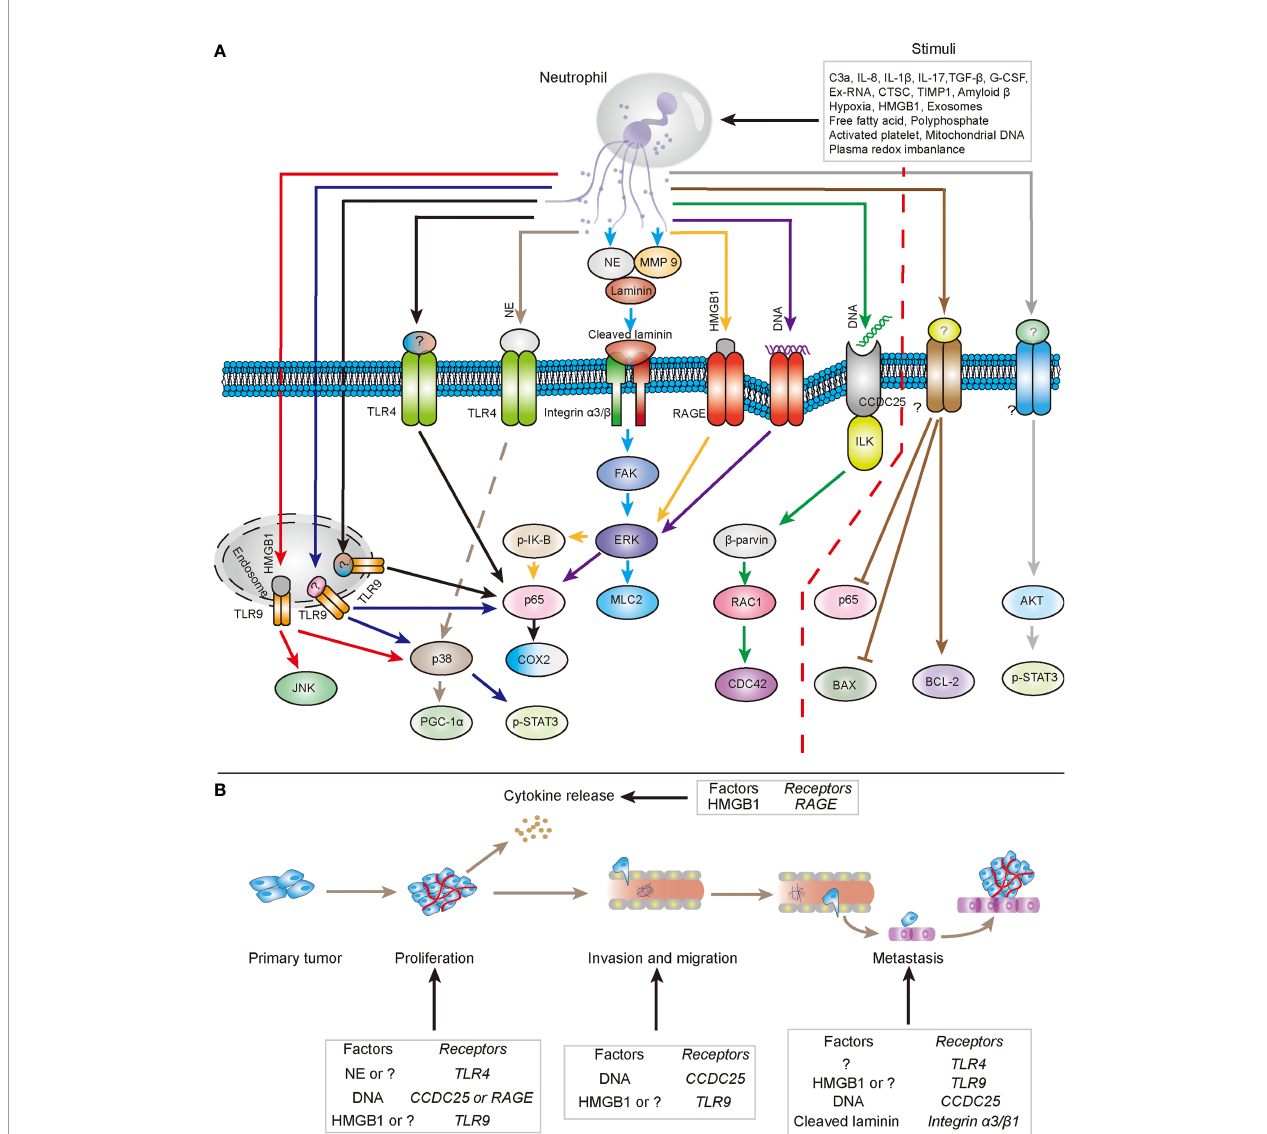
FIGURE 1 | The mechanisms by which NETs directly promote tumor progression. (A) In several types of stimuli in tumor tissues, neutrophils expel their DNA and cytoplasmic proteins to form extracellular structure to participate in tumor progression. NETs-DNA could interact with RAGE and CCDC25 respectively to be involved in the transduction of intracellular tumor-promoting signals, which facilitate tumor progression. Additionally, NETs associated protein components, such as NE, MMP9 and HMGB1, also could cooperate with respective receptor to stimulate downstream pathways to fuel the malignancy of tumors. Question marks (?) represent relevant functional components of NETs and related receptors that have not been clearly stated (especially the right side of red dotted line). (B) Components of NETs involved in the cytokine release, proliferation, invasion, migration and metastasis of tumor cells through respective relevant